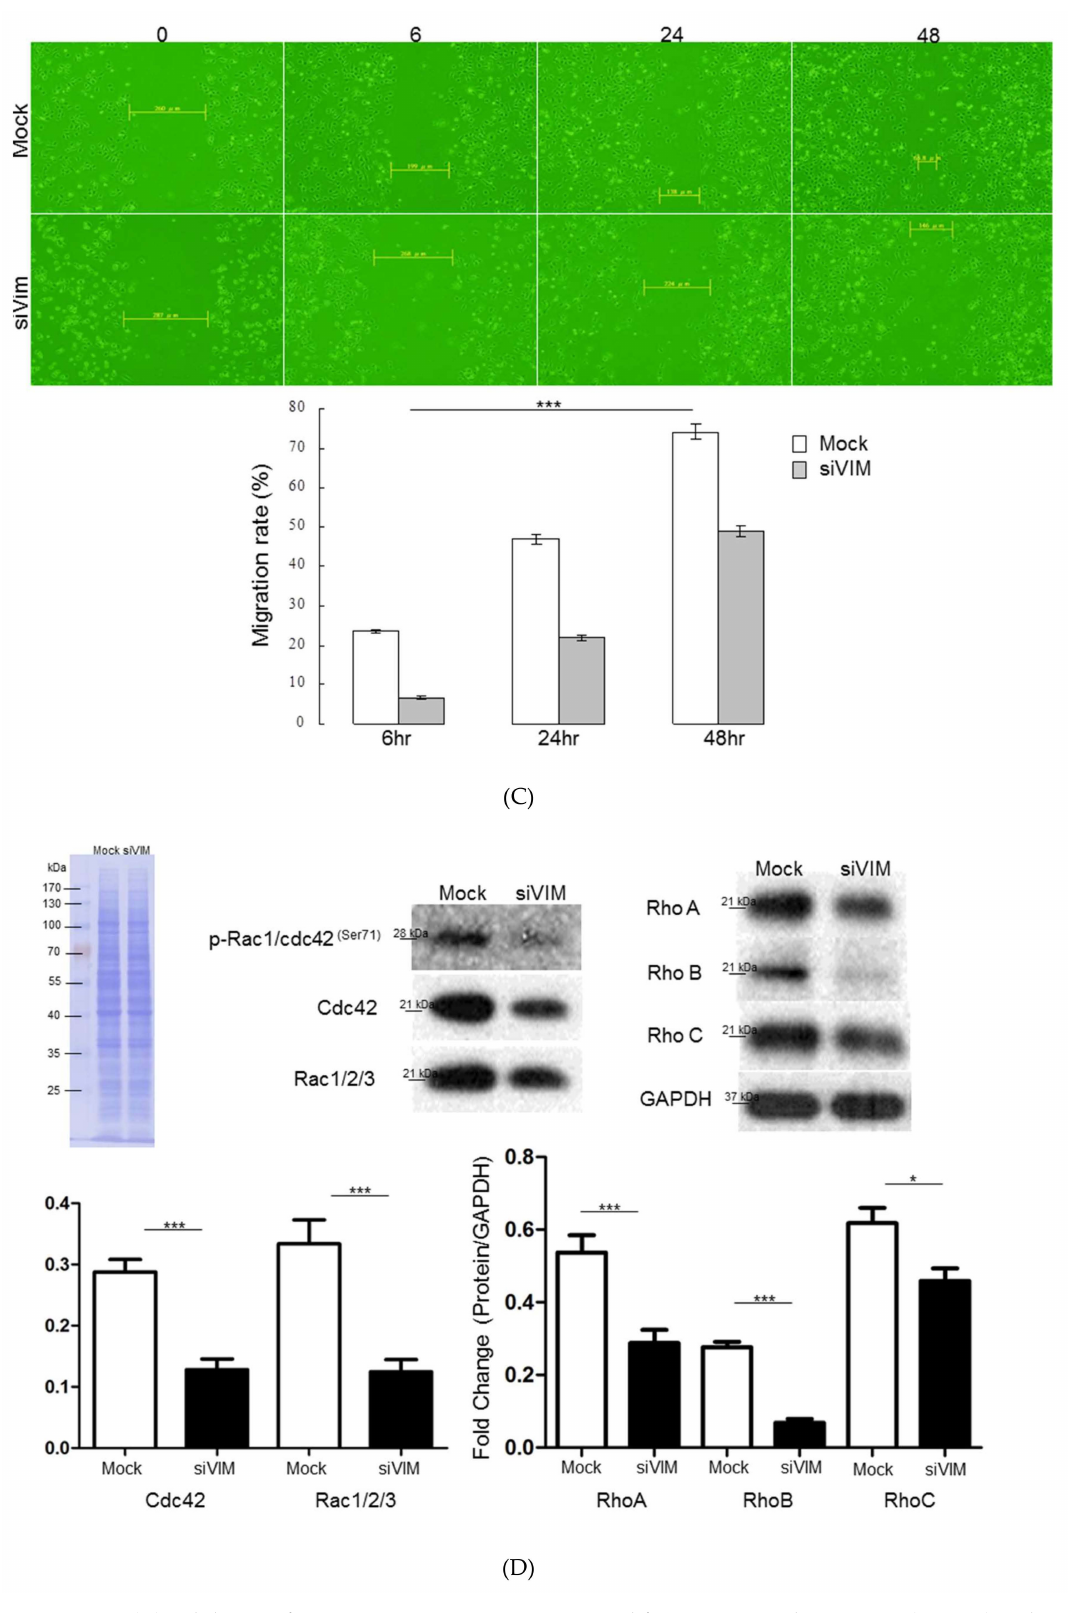
Figure 3. ( A ) Validation of α –SMA, vimentin, peroxisome proliferator activated receptor- γ (PPAR γ ) and proliferating cell nuclear antigen (PCNA) expression in hepatic stellate cell (HSC-T6 cells applied with vimentin with RNA silencing (siVIM) or without (Mock) siVIM by Western blotting. GAPDH was used as an internal control. PVDF membrane stained with Coomassie blue R-250 was utilized to